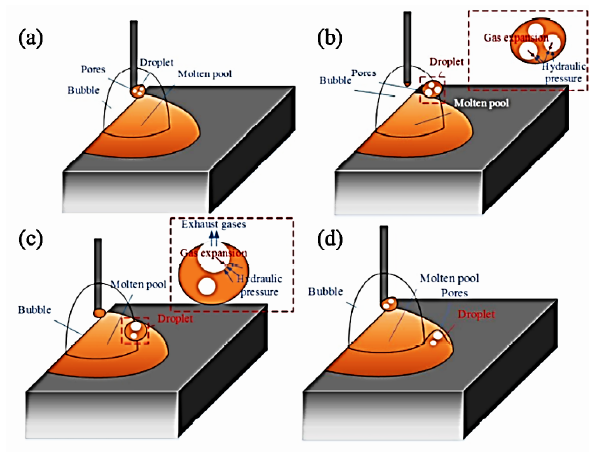
Figure 6: Schematic force analysis of porosity gas expansion during droplet transitions [20].